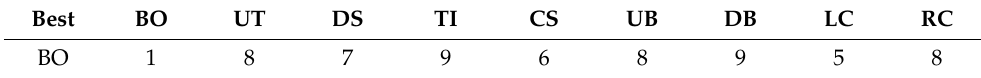
Table 5. Best criteria preferences.